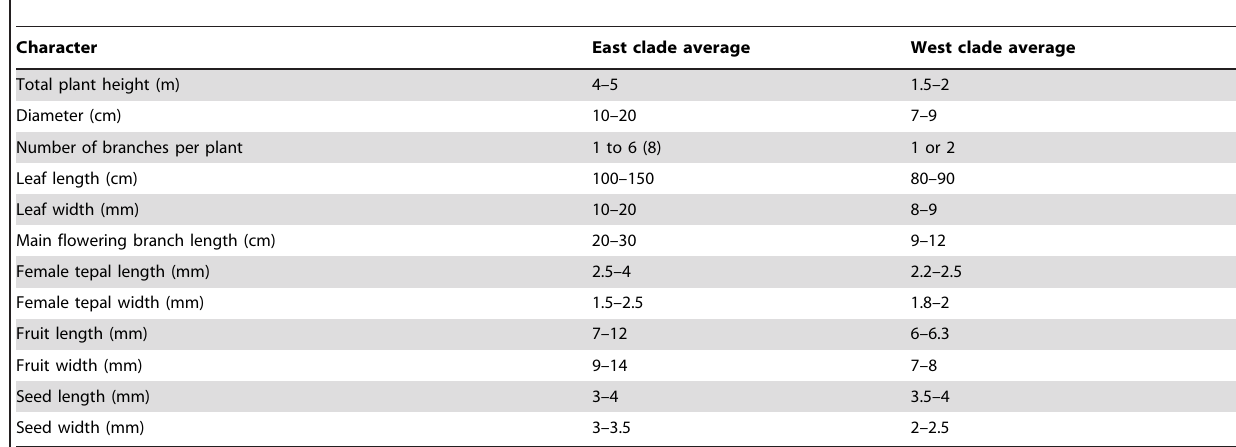
Table 4. Vegetative and floral morphological characters scored on specimens from the east and west clades of N. parviflora along of the Trans-Mexican Volcanic